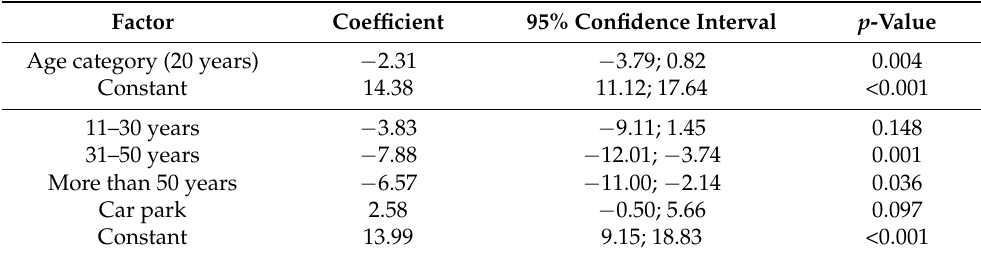
Table 2. Building factors and outdoor sources relevant for formaldehyde levels. Coefficients in µg/m 3 .